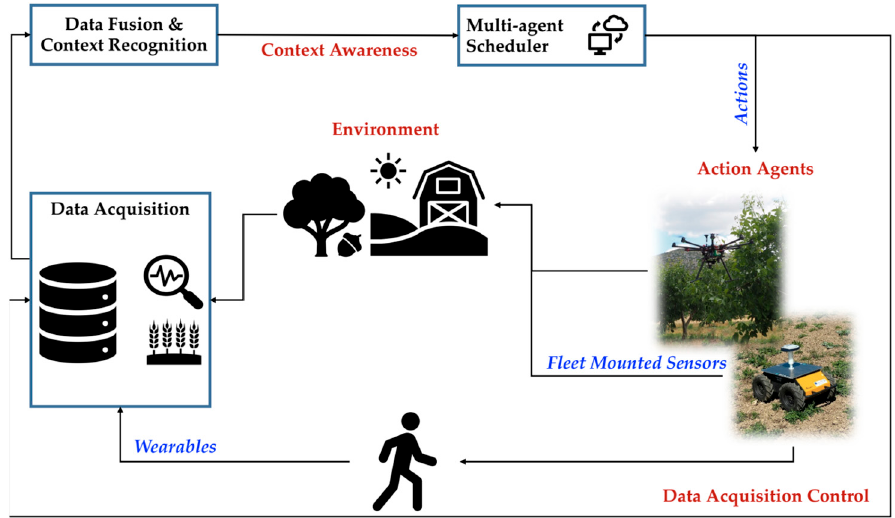
Figure 2. Graphical representation of the conceptual human–robot synergy system.